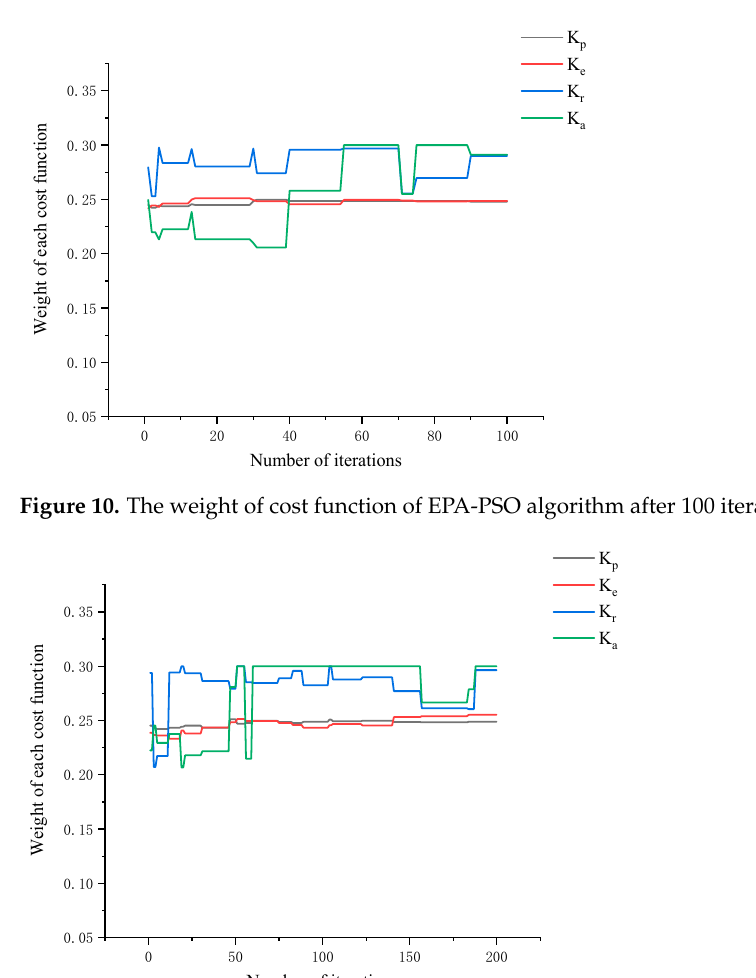
Figure 9. The trust of particles in speed jump.